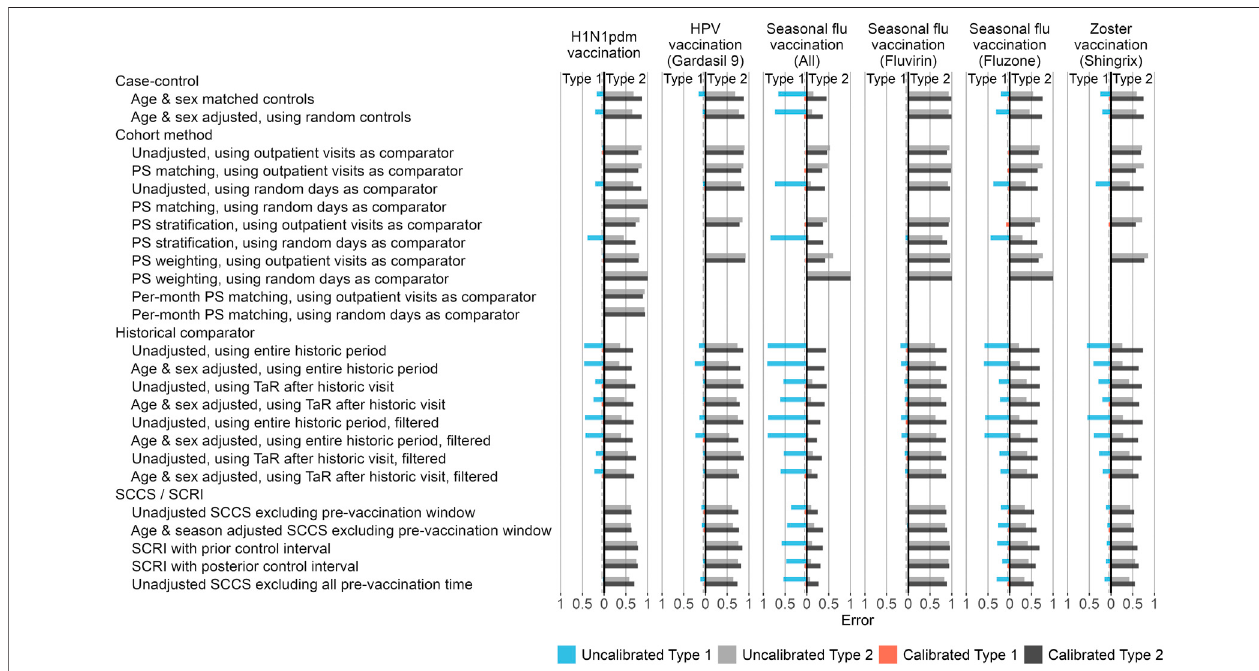
FIGURE4| Type1and2errorbeforeandafterempiricalcalibration.Foreachmethodvariationandvaccinegroup,thetype1and2errorbeforeandafterempirical calibrationintheOptumEHRdatabaseareshown.Thex-axisindicatesthetype1error(highervaluestotheleft)andtype2error(highervaluestotheright),basedonthe (calibrated)one-sidedp-value.Thedashedlineindicatesnominaltype1errorof5%.HPV=Humanpapillomavirus,PS=PropensityScore,SCCS=Self-ControlledCase Series, SCRI = Self-Controlled Risk Interval, TaR = Time-at-Risk.